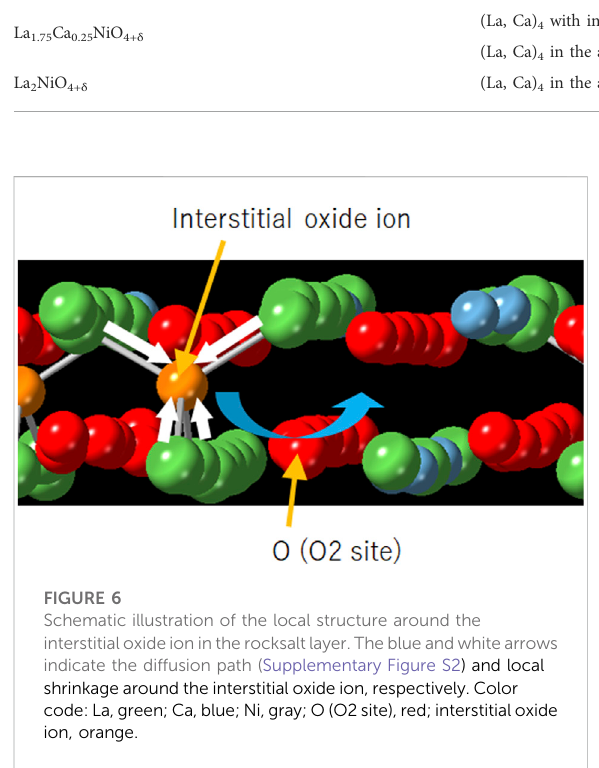
FIGURE 6 Schematic illustration of the local structure around the interstitialoxideionintherocksaltlayer.Theblueandwhitearrows indicate the diffusion path (Supplementary Figure S2) and local shrinkage around the interstitial oxide ion, respectively. Color code:La,green;Ca,blue;Ni,gray;O(O2site),red;interstitialoxide ion, orange.